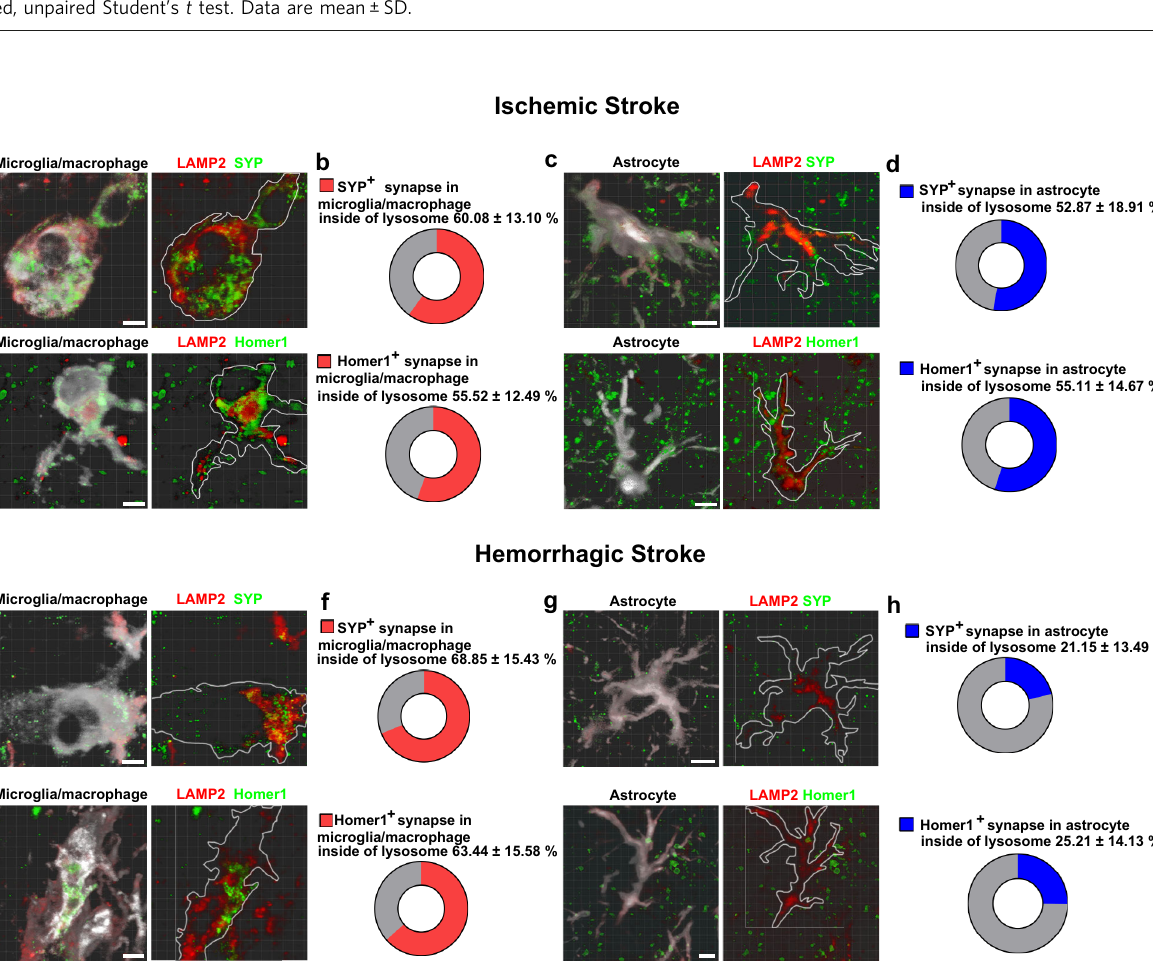
Fig. 3 Microglia/macrophages and astrocytes digested synaptic elements through lysosome in stroke mouse brain. a – d Representative images showed SYP + (green) and Homer-1 + (green) signals in LAMP2 + lysosomes (red) in Iba-1 + microglia/macrophages (white) and GFAP + astrocytes (white) in the ischemic brain. e – h Representative images showed SYP + (green) and Homer-1 + (green) signals in LAMP2 + lysosomes (red) in Iba-1 + microglia/ macrophages (white) in the hemorrhagic brain, but rarely detected in GFAP + astrocytes (white). Bar = 10 µ m. a , c , e , g n = 4 mice per group. Data are mean ± microglia/macrophage-speci fi c MEGF10 KO or MERTK KO mice had higher expression of SYP and Homer-1 (Fig. 5p, q), whereas astrocyte-speci fi c MEGF10 KO or MERTK KO mice had compar- able expression of SYP and Homer-1 (Fig. 5r, s). To evaluate the overall synapse density, we also colabeled pre- and postsynaptic markers and measured the density of SYP + presynapses, PSD95 + postsynapses, and SYP + /PSD95 + synapses, to show the overall synapse density. The densities of SYP + presynapse, PSD + postsynapse and SYP + /PSD95 + synapse were increased in microglial and astroglial cKO mice after ischemic stroke, as compared with the control (Fig. 5i – k). In hemorrhagic mice, synapse density was increased in microglial cKO mice but not in astroglial cKO mice (Fig. 5t – v).